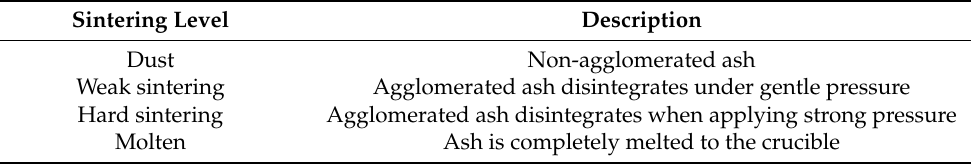
The percentage values of the calcined samples are divided by the maximum value of 10%. The values are classified on dust 0.25, weak sintering 0.5, hard sintering 0.75 and molten 1. The percentage of accumulated slag on sieves of 3.35, 2 and 0.85 mm is divided by the value of